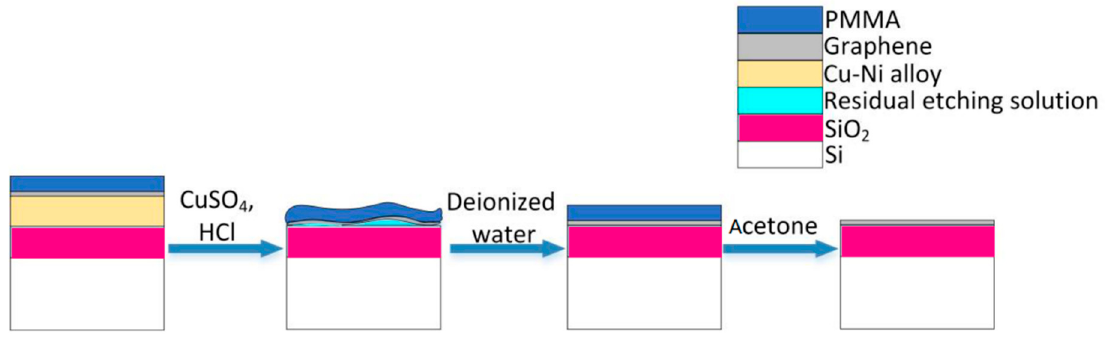
Figure 2. Process of “transferring” the graphene grown by Cu-Ni alloy onto its own SiO 2 /Si substrate.